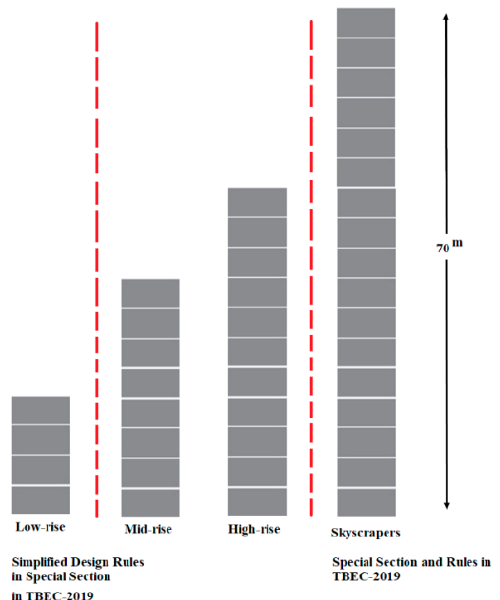
Figure 2. Schematic representation of buildings according to their heights.